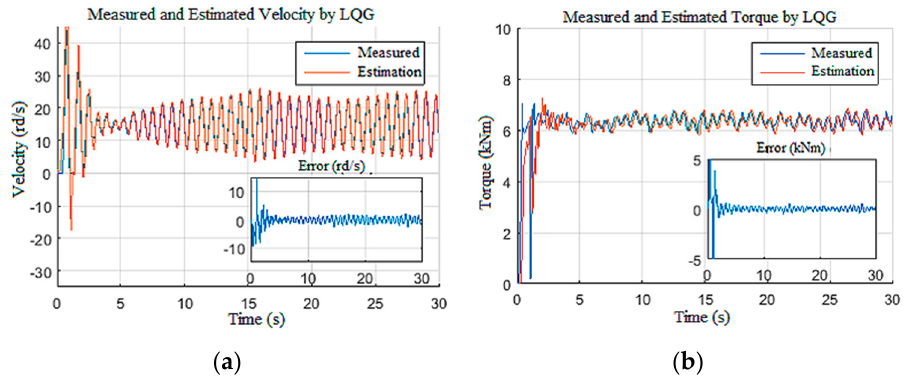
Figure 15. Outputs of the observer in Scenario 2: ( a ) drill bit velocity; ( b ) Tob.